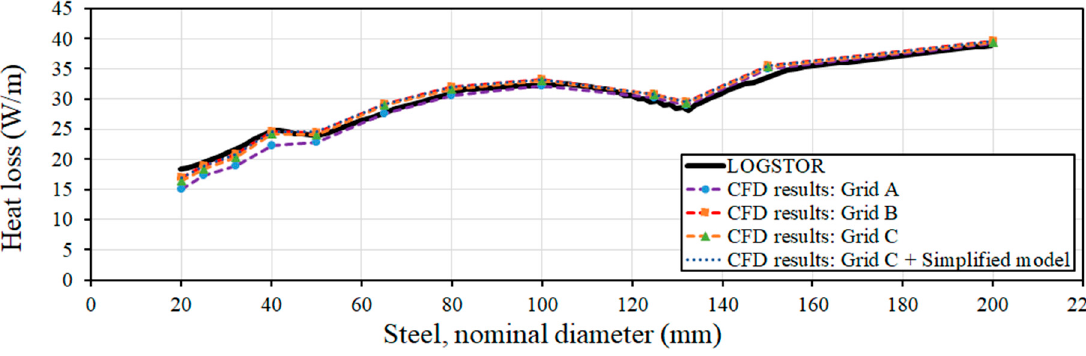
Figure 3. The mesh grid sensitivity analysis and validation of the CFD results.